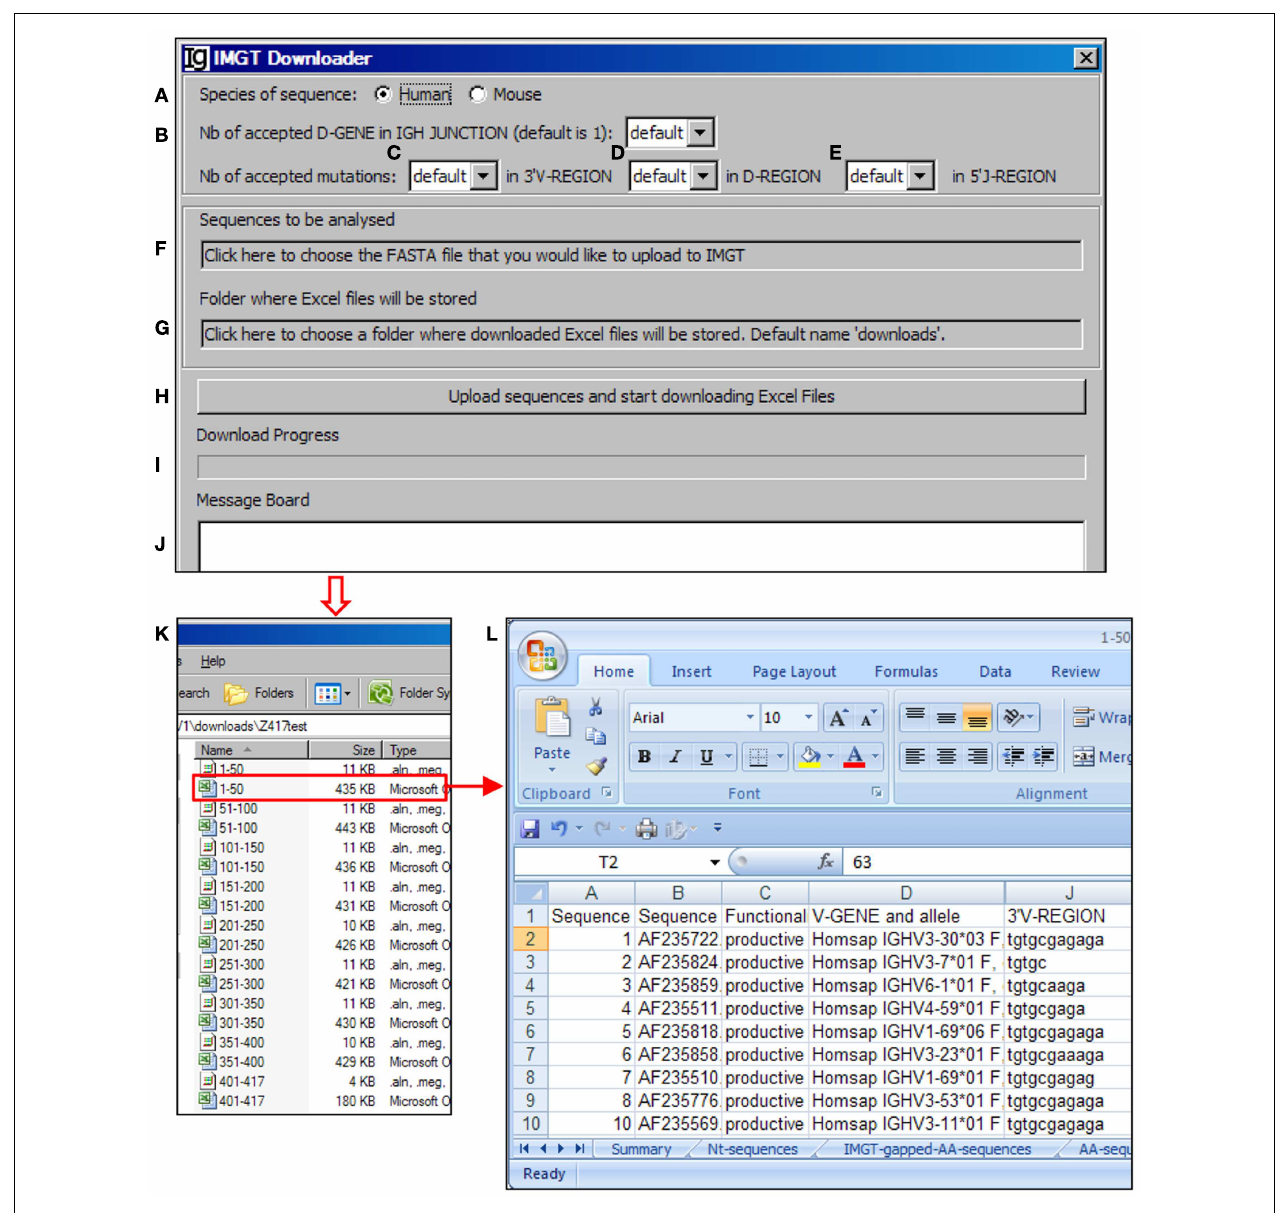
user can upload the IgH sequences (in FASTA file) (F) and specify the directory where the downloadedV-QUEST analysis Excel files can be stored (G) .The analysis can be started by clicking the Upload sequences and start downloading Excel Files bar (H) .The analysis progress (I) and message during the analysis (J) will also be shown.TheV-QUEST analyses results of the test sequences are downloaded to a user specified location (K) .The detailed results of sequence 1–50 are shown in theV-QUEST format (L)